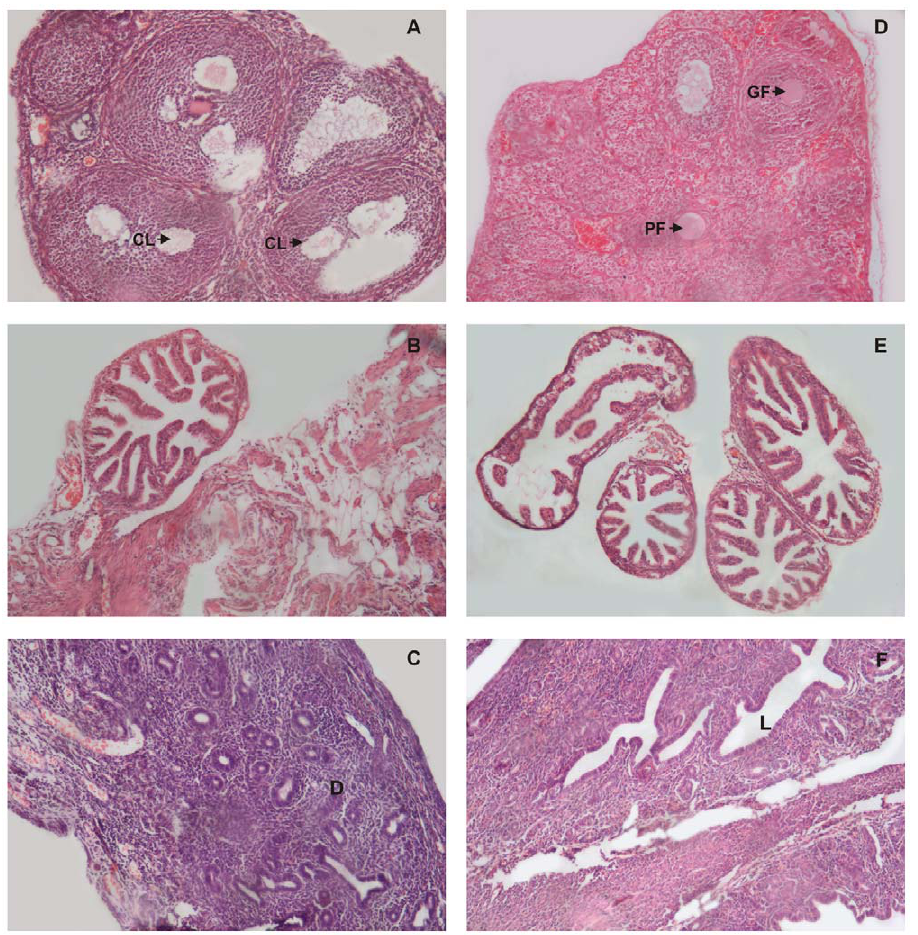
Figure 2. Histological examination of reproductive organs on day 19 after intravaginal administration of PBS (Control) or spermagglutinating strain of S.aureus for 10 consecutive days. Light microscopic images of sections of reproductive organs on day 19 of control mice showing follicles and corpus luteum (CL) in the ovary and proliferation of endometrium in the uterus characteristic of pregnancy (A & C), in contrast to sections from S. aureus treated mice showing no such pregnancy related changes (D & F). Fallopian tubes from control and treated mice were indistinguishable (B & E). Original magnification 100X.